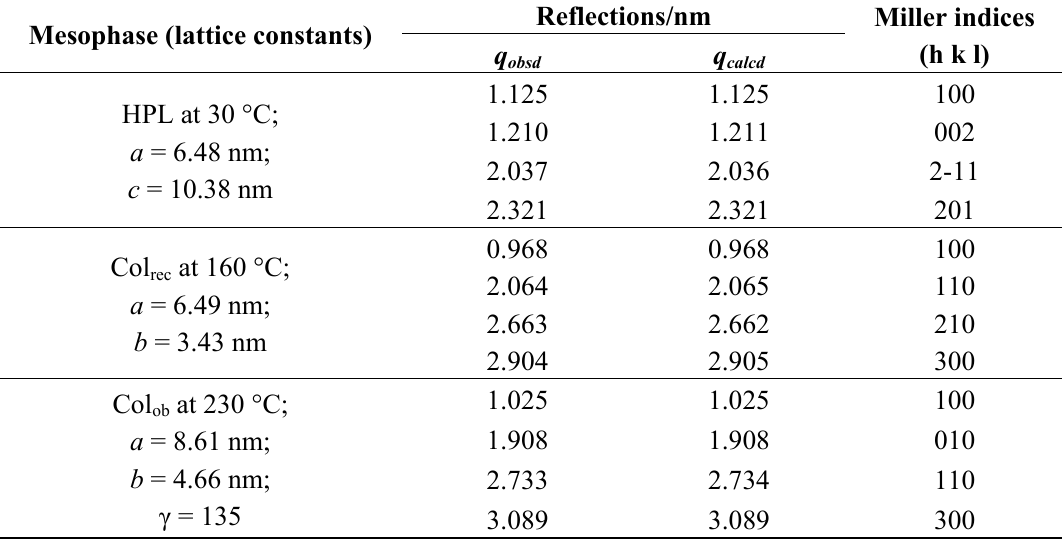
Table 2. Small-angle X-ray diffraction data for molecule 1a in the bulk